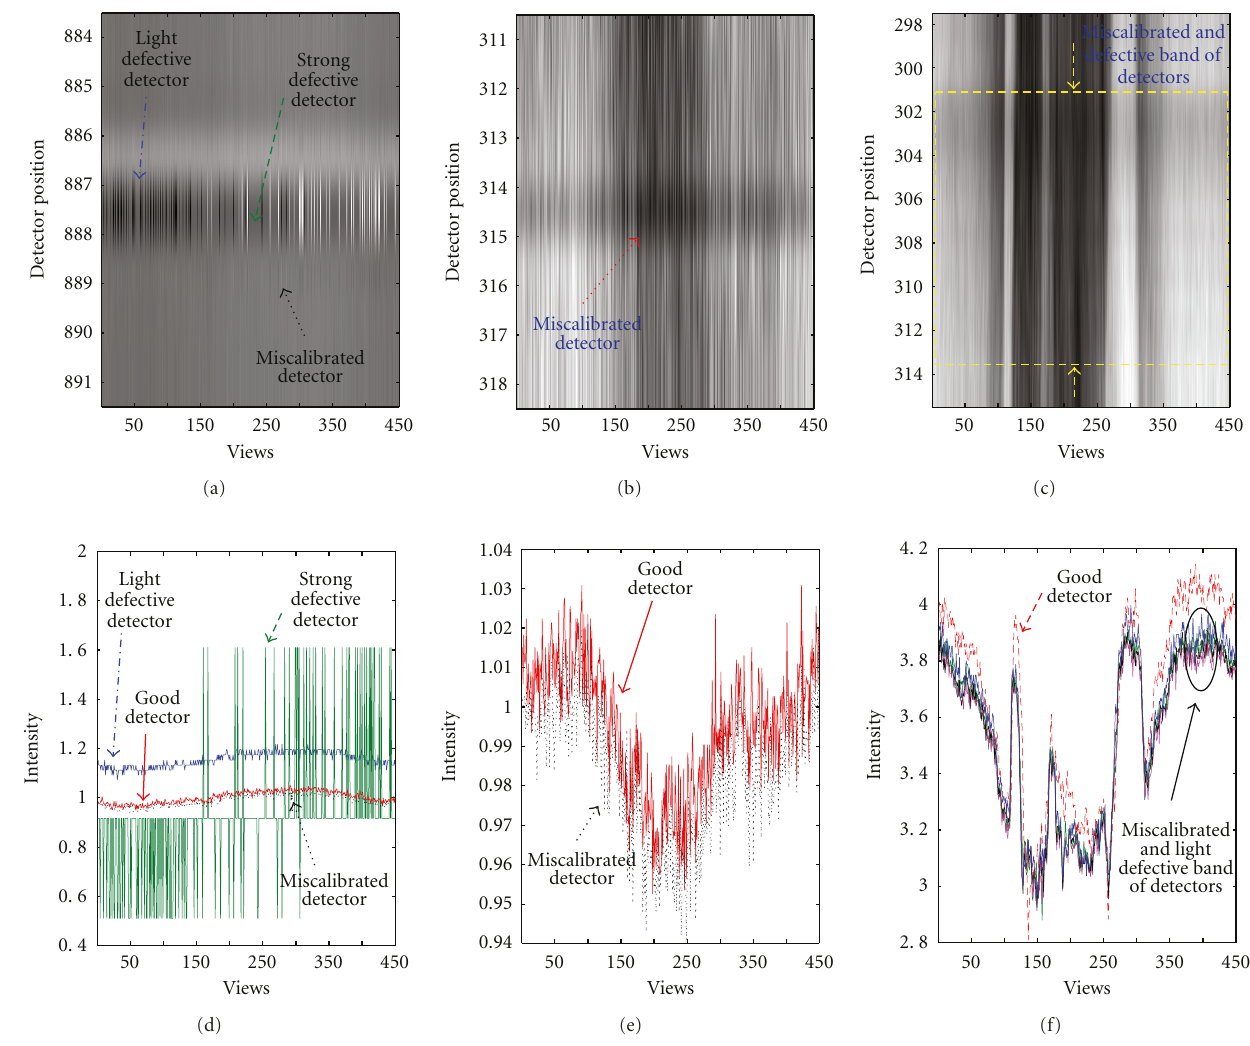
Figure 5: Various types of sinogram data investigated by the proposed algorithm. Cropped view of the sinogram showing (a) strong and light defective detector elements along with a miscalibrated one, (b) isolated miscalibrated detector element, (c) band of detector elements where both defective and miscalibrated detectors are present; (d), (e), and (f): plot of corresponding detector element